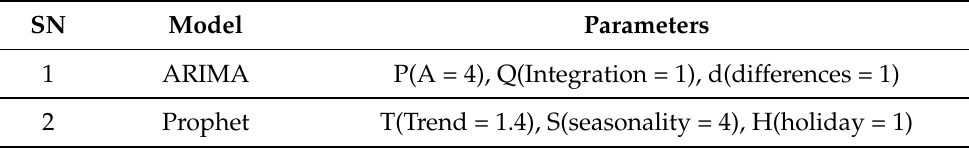
Table 7. Optimized parameters for the ARIMA and Prophet